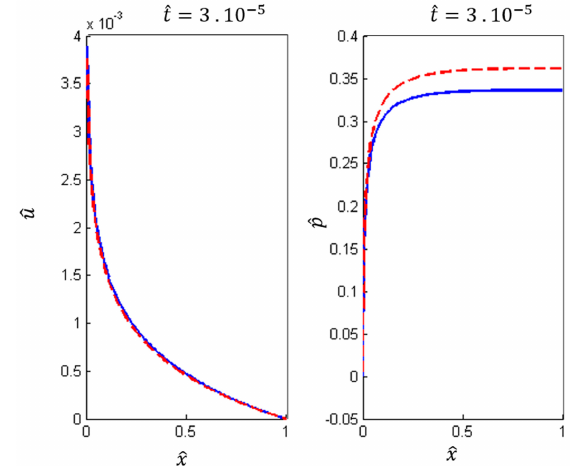
Figure 4. Comparison of the displacement (left) and pore pressure at time ˆ t = 3 × 10 − 5 with hybrid splitting (continuous blue line) and fully coupled (discontinuous red line) methods with only one iteration for linear material